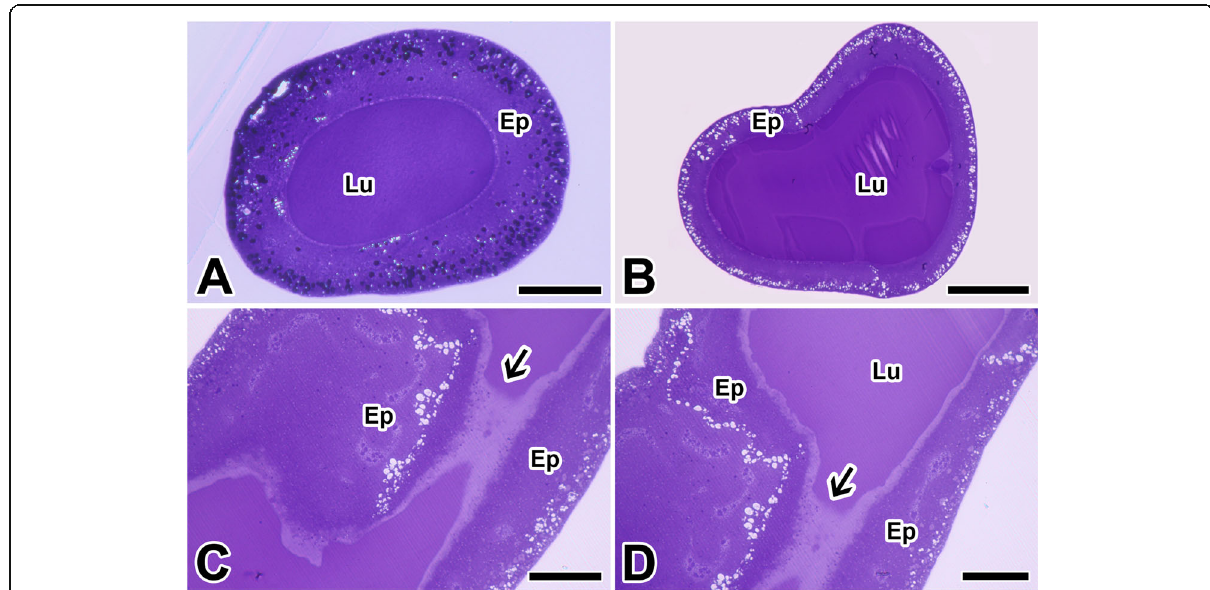
Fig. 4 Cross section of the silk gland in the caddisworm H. nigrovittatus. a , b Cross section of anterior ( a ) and posterior ( b ) silk gland showing glandular epithelium (Ep) and internal lumen (Lu). c , d Longitudinal section of the silk gland illustrating an annular narrowing (arrows) at the